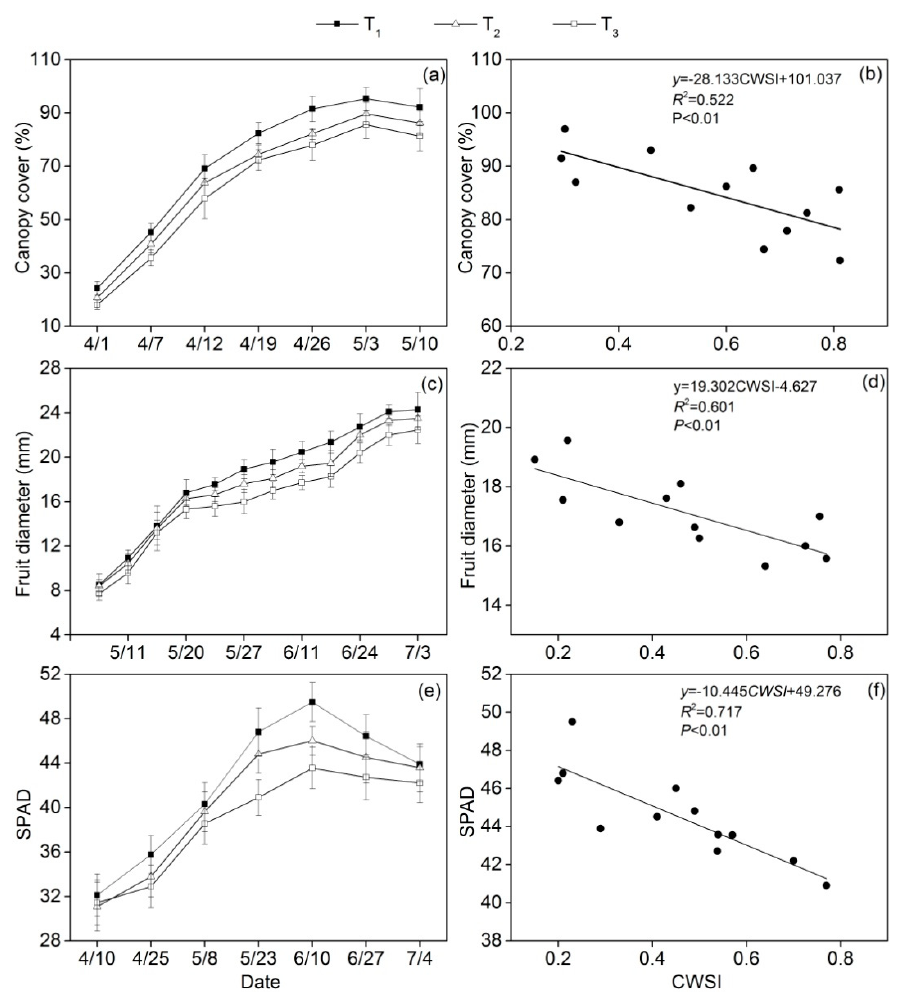
Figure 7. The fitting chart of the CWSI with canopy cover, fruit diameter, and SPAD. ( a , c , e ) represent the change in the canopy cover, fruit diameter, and SPAD, respectively, and ( b , d , f ) represent the fitting equations of the above indexes and the CWSI, respectively. Data are the means ± SE of three replicates. T 1 represents 100% M, T 2 represents 80% M, T 3 represents 60%.